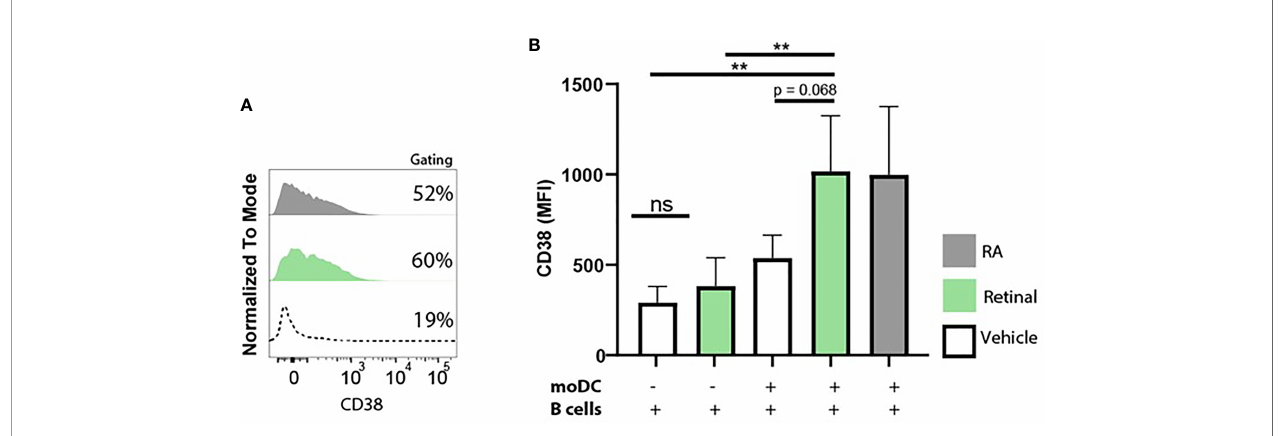
FIGURE 5 | Monocyte-derived dendritic cells convert retinal into retinoic acid, and increase B cell CD38 expression. Naive B cells and monocyte-derived dendritic cells were co-cultured in vitamin A de fi cient medium in the presence of TD-dependent stimuli for 9 days, including interleukin-4, anti-CD40 and anti-IgM antibodies. As a negative control naive B cells and monocyte-derived dendritic cells were co-cultured with vehicle alone. (A) Representative histogram of CD38 expression on naive B cells supplemented with natural retinal (green) or RA (black) during the 9 day coculture. Vehicle treatment is indicated with the dotted line. As a negative control, cocultures were treated with vehicle alone (dotted line). (B) Quanti fi cation CD38 mean fl uorescent intensity of naive B cells supplemented with unmodi fi ed retinal (green), RA (black) or vehicle treated cells (white) from 4 separate experiments with individual blood donors (n=4). Data are presented as mean ± SD. ANOVA; **p <